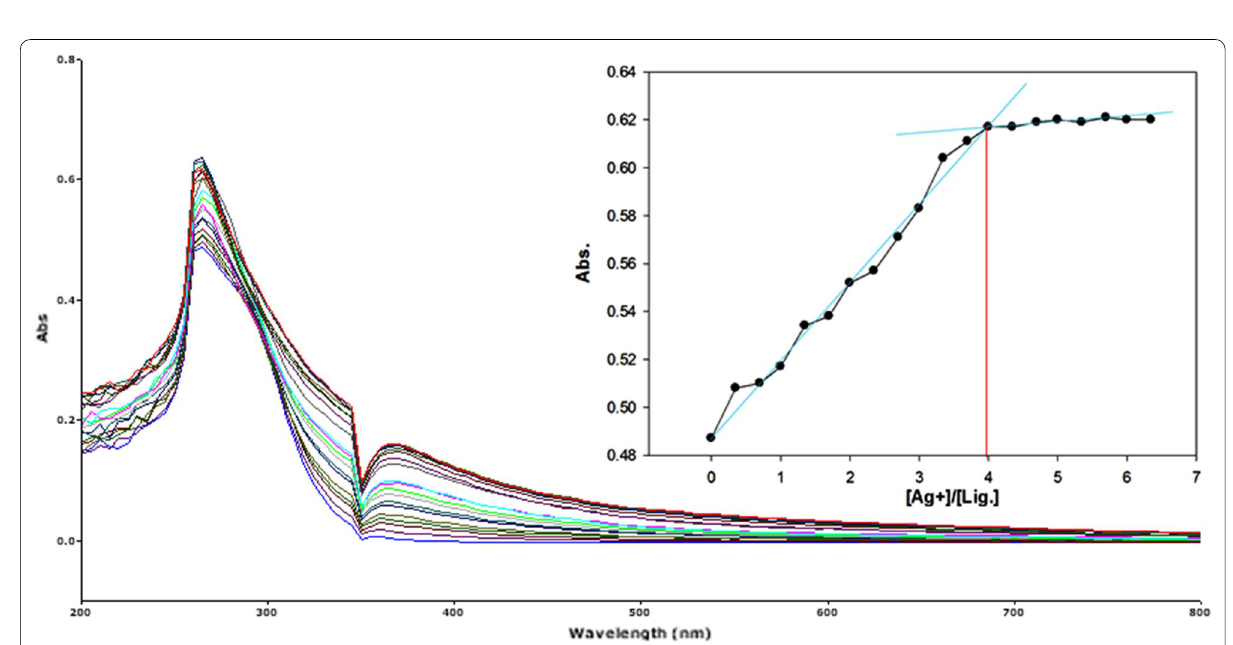
Fig. 16 Titration of isomer 1A vs Ag + ( Inset Binding behavior